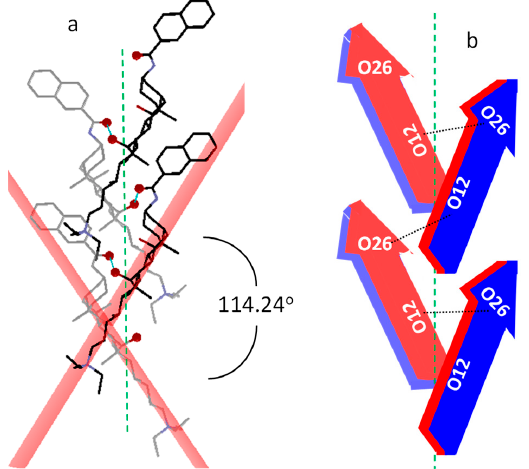
Figure 7. ( a ) The packing of the molecules around the 2 1 axis to define the handedness of the molecular helical disposition. For clarity, hydrogen atoms and iodide ions have been hidden and O12 and O26 atoms highlighted. ( b ) The scheme of this arrangement based on the arrow model of Figure